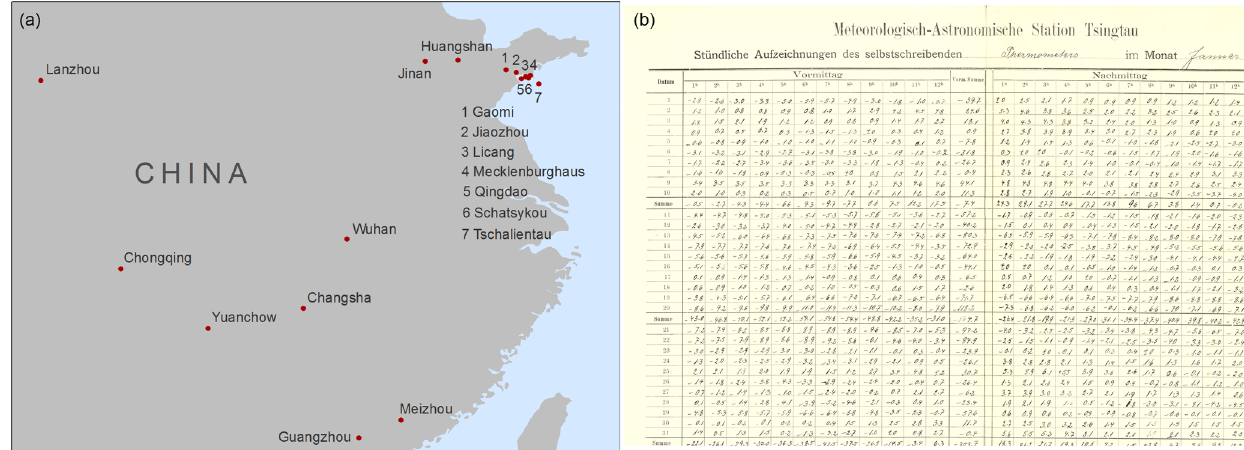
Figure 1. Positions of the 14 stations of the German Marine Observatory in China (a) ; handwritten observations of Qingdao (b) from the archive of the German Meteorological Service in Hamburg,